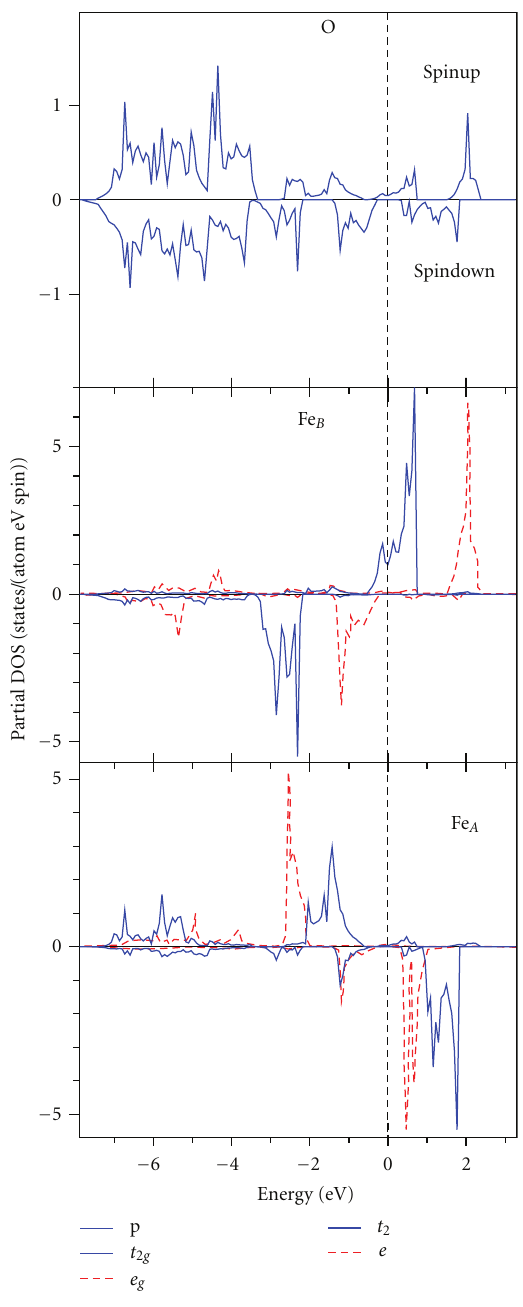
Figure 2: LSDA partial DOS of Fe 3 O 4